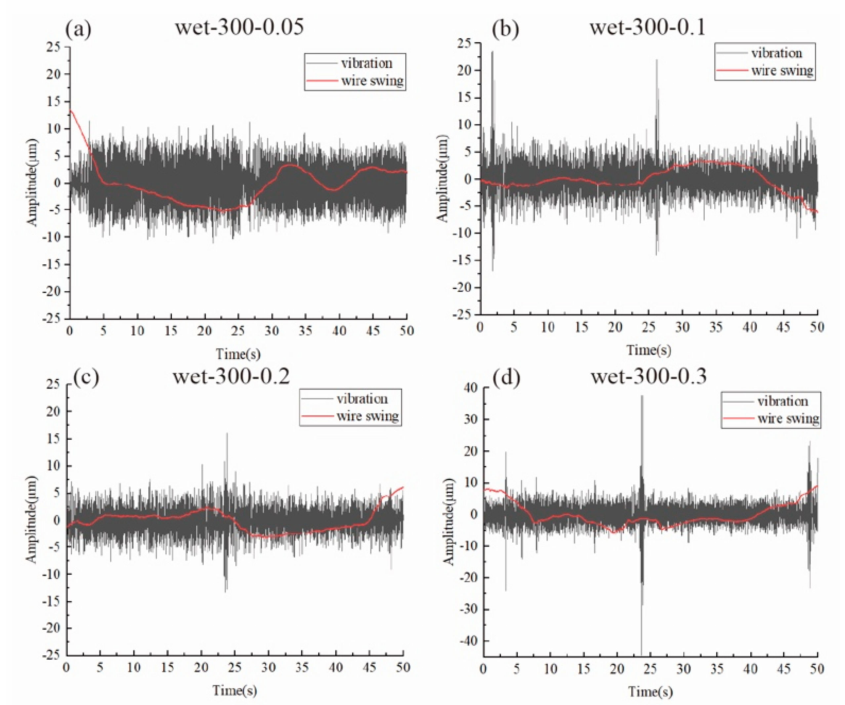
Figure 6. The wire vibration and wire swing motion during wet